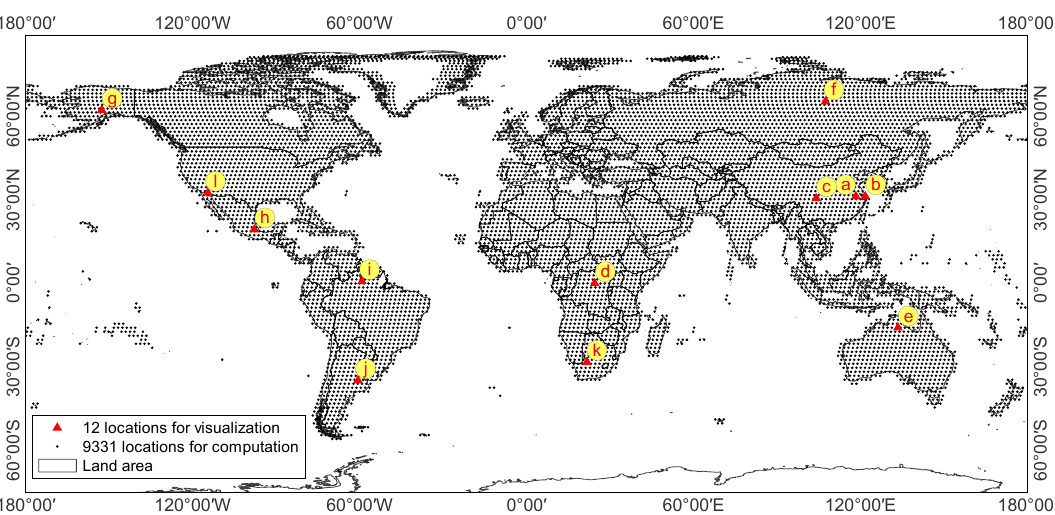
Figure 2. Map of the test sample and visualization sample distribution. The test sample locations were uniformly spread throughout 9331 sites based on the available Landsat 8 observations in 2019. From May to September 2020, the 12 visual points (see Table A1) were restricted to the Landsat 8 observation site. They were chosen on the basis of cloud cover and geographical location.